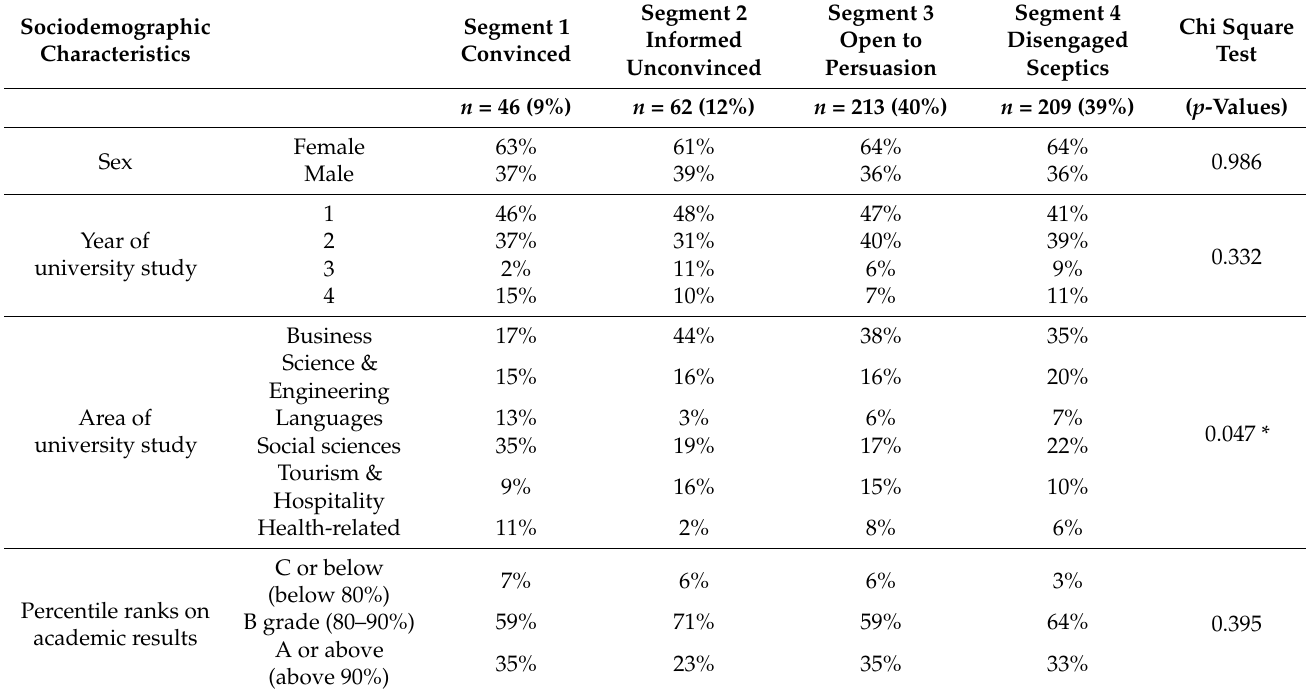
Table 3. Sociodemographic characteristics by